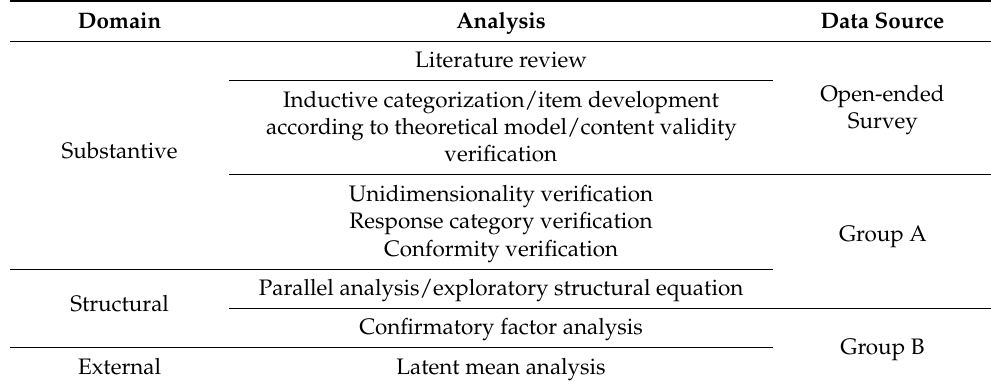
Table 3. Composition of the